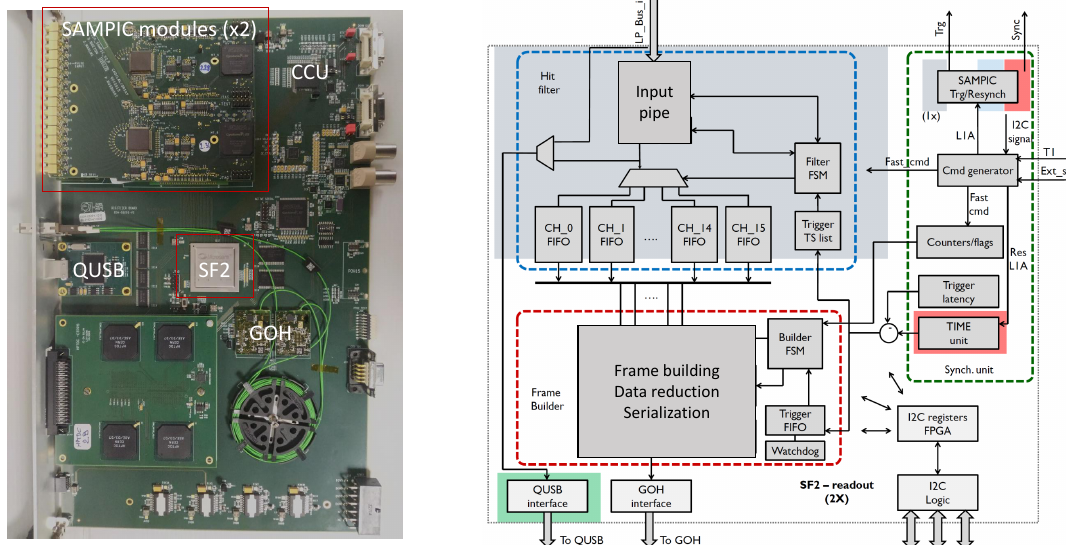
Figure 4. ( On the left ) a picture of the RMB fully equipped. ( On the right ) a scheme of the readout section of the firmware developed for the SF2